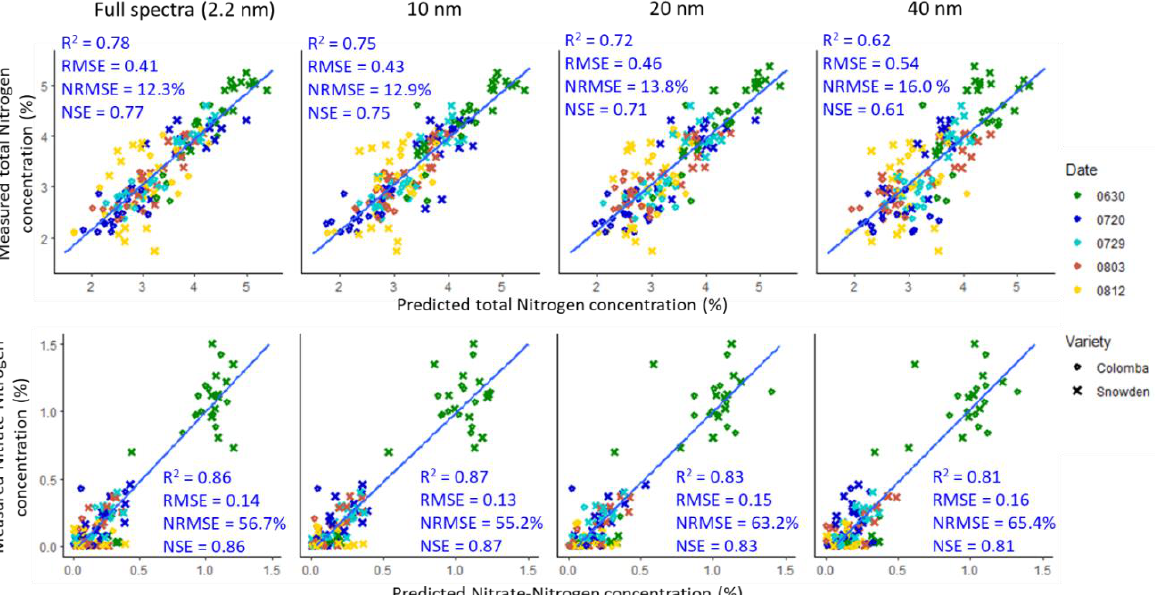
Figure 3. Scatterplots of the predicted and measured potato N concentrations. The predicted values were from PLSR models with the reflectance of hyperspectral narrow (2.2 nm) and broad bands (10, 20, and 40 nm). The blue solid line in each plot represents the line of y = x .